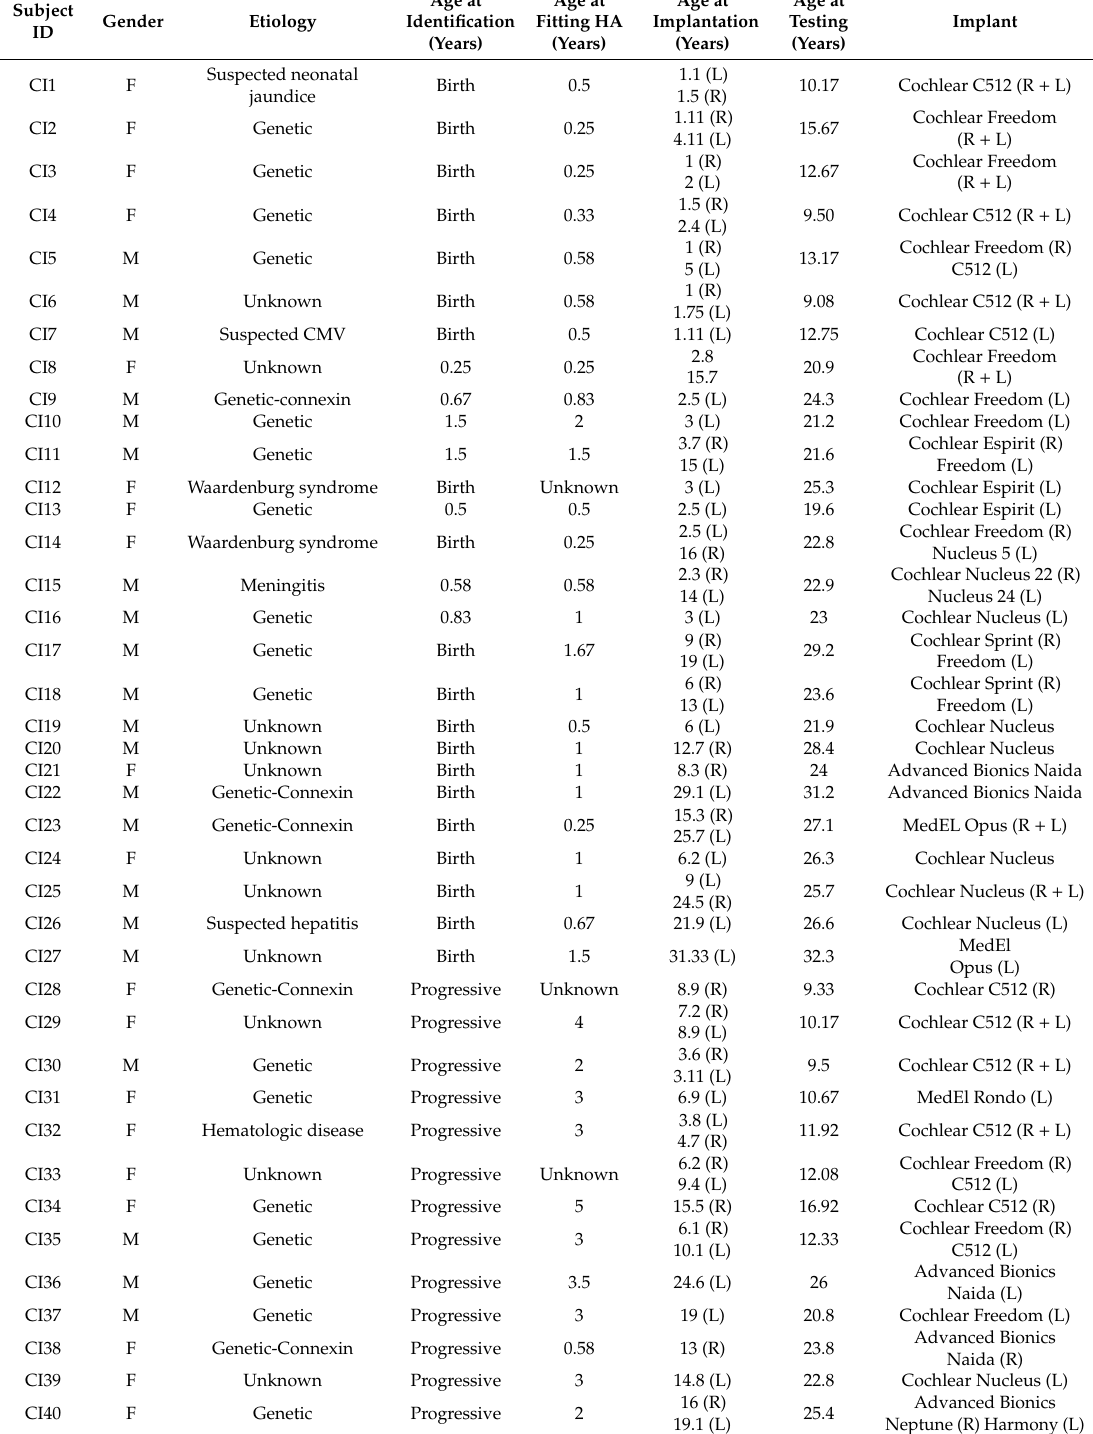
Table 1. Demographic details for the cochlear implant (CI) users who participated in the present study. Participants CI1–CI27 were prelingually deafened individuals. Of these participants, CI1–CI16 were early-implanted (before the age of 4 years), and CI17–CI27 were late-implanted (after the age of 6 years). Participants CI28–CI40 were individuals with progressive